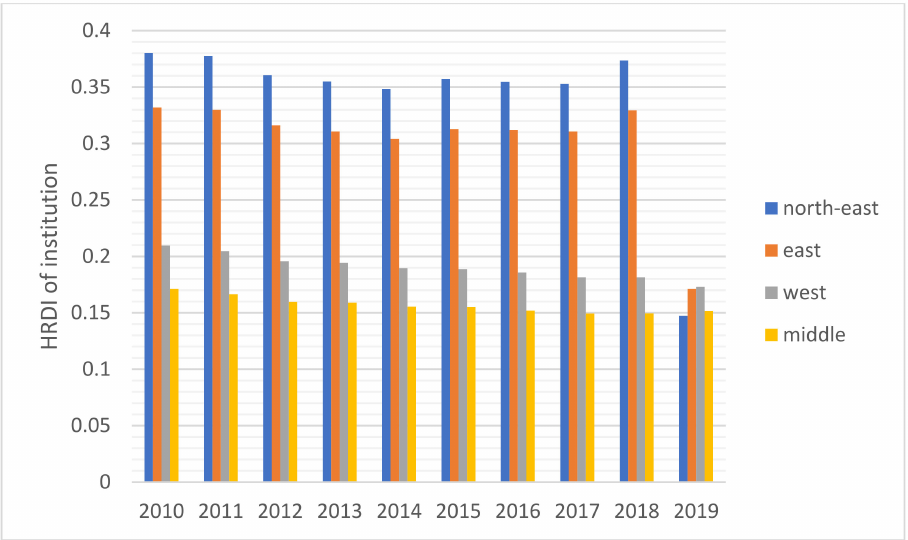
Figure 2. The HRDI of the health resources in institutions when dividing China into four